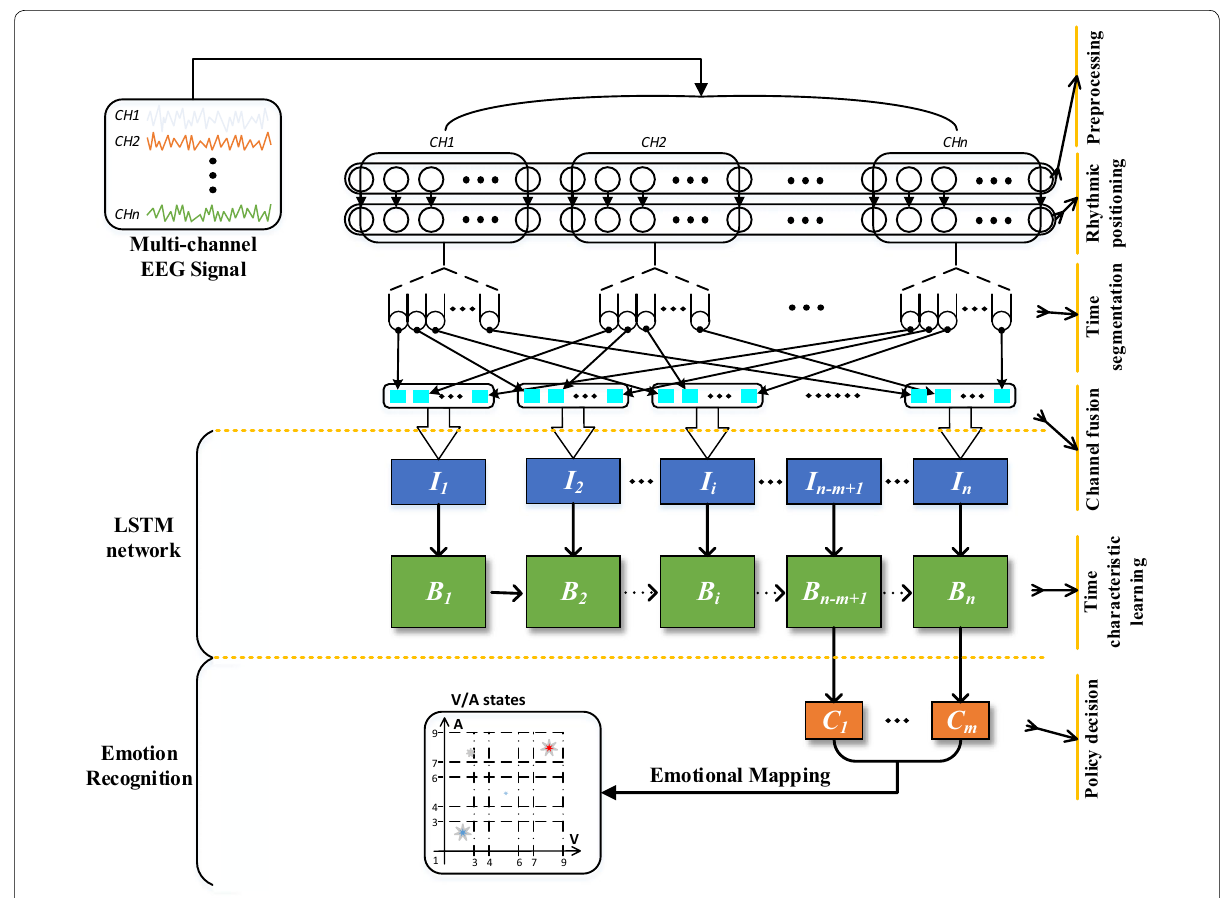
Fig. 2 An emotion recognition model inspired by “rhythm–time”